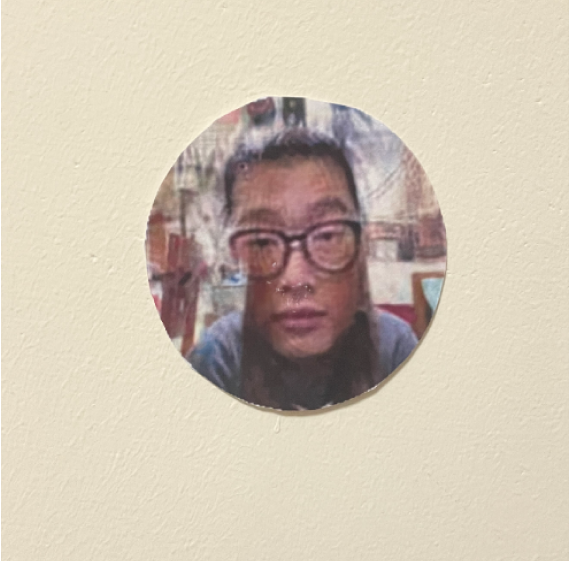
Figure 6. Adversarial faces cut into